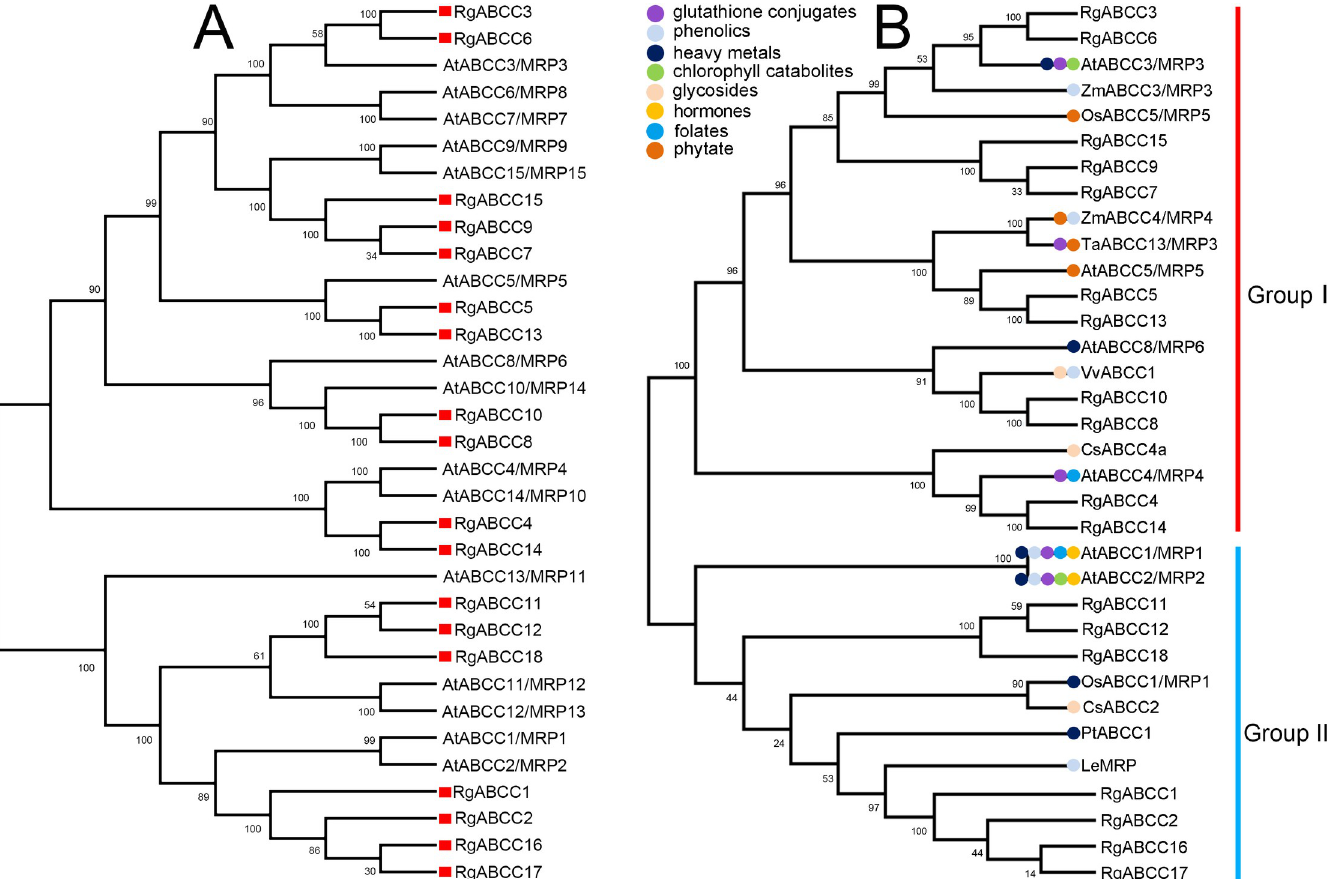
Fig 1. Phylogenetic alignment of plant ABCCs/MRPs. (A) Phylogenetic tree of ABCCs/MRPs from R . glutinosa and A . thaliana ; (B) Phylogenetic tree of the RgABCCs and functionally characterized ABCCs/MRPs from other plants (Note: Coloured dots indicate the class of transported substrates for the functionally characterized